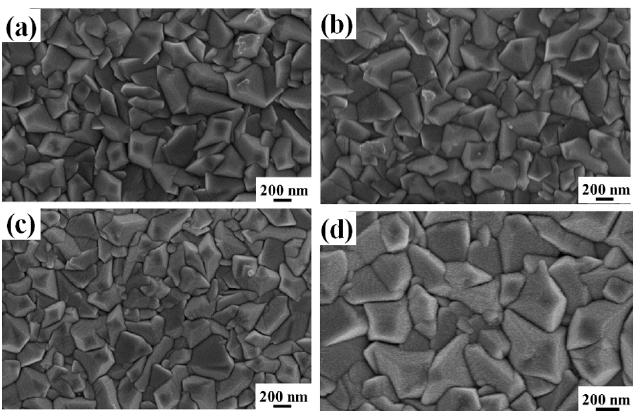
Figure 3. Representative SEM images of the surface of the as-deposited FTO (substrate A) on which the AuPd film is deposited with increasing the amount of deposited AuPd: ( a ) 4.3 nm; ( b ) 7.5 nm; ( c ) 29.2 nm; and ( d ) 48.6 nm.